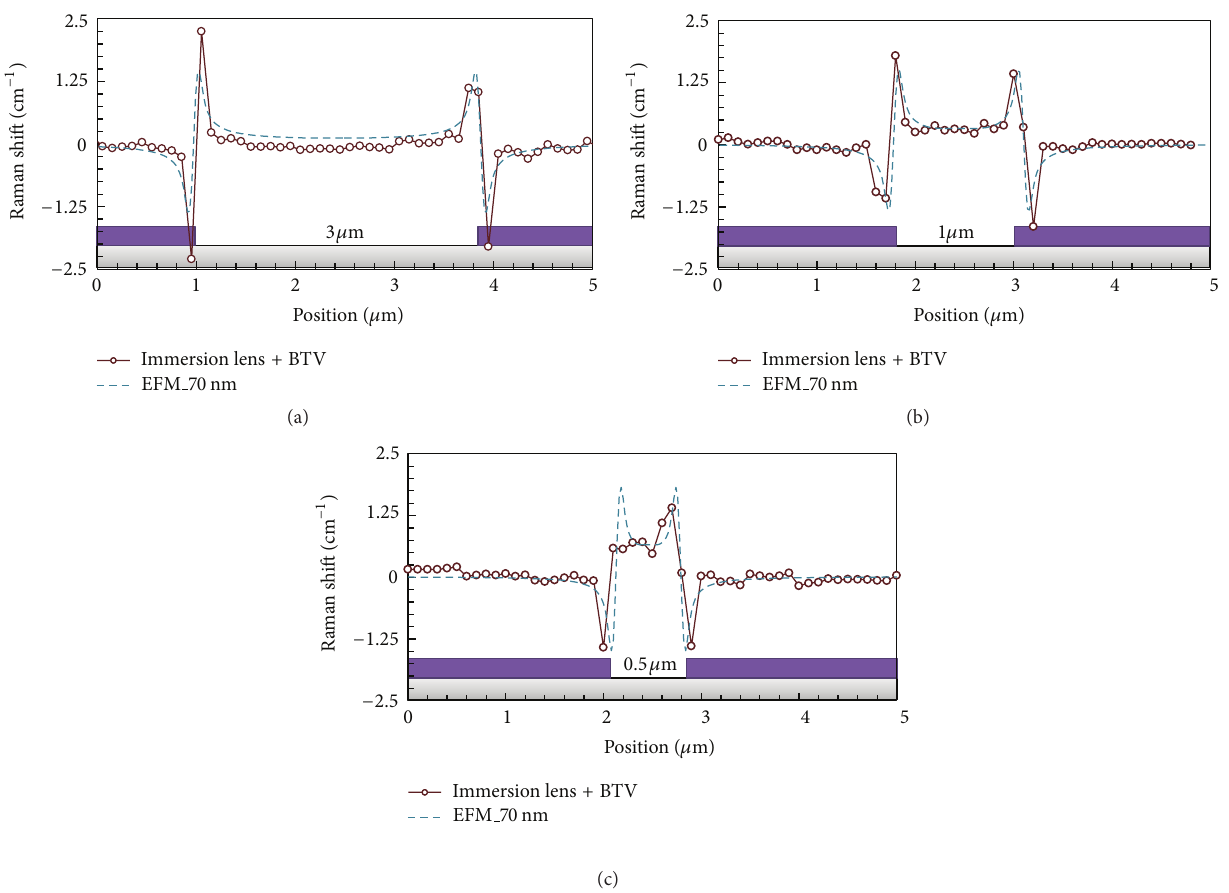
Figure 8: One-dimensional profiles of Raman shifts in the center of L&S pattern obtained by super-resolution Raman spectroscopy and EFM calculation with immersion lens (in space widths of (a) 5, (b) 3, and (c) 1 𝜇